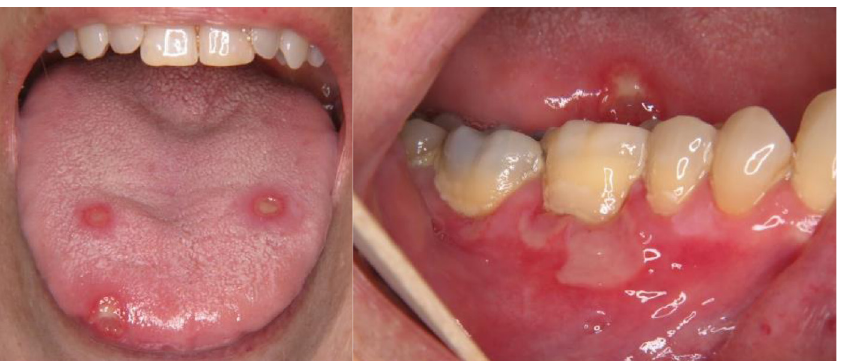
Fig. 1. Appearance of ulcers at the fi rst consultation.